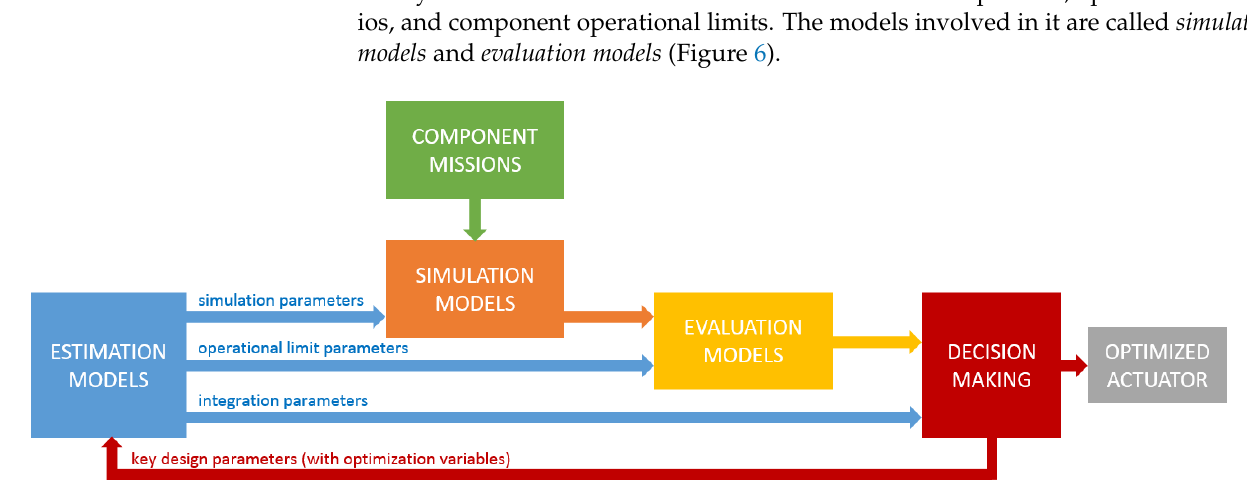
Figure 6. Structure of model-based preliminary